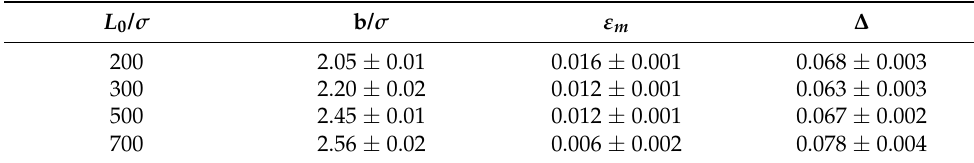
Figure 5. Wrinkling amplitude over the whole range of uniaxial compression. The superimposed lines are the best-fit curves according to Equation (5). The best-fit parameters are summarized in Table 1. The amplitude is in units of σ , see Section 3. Table 1. Best-fit parameters of Equation